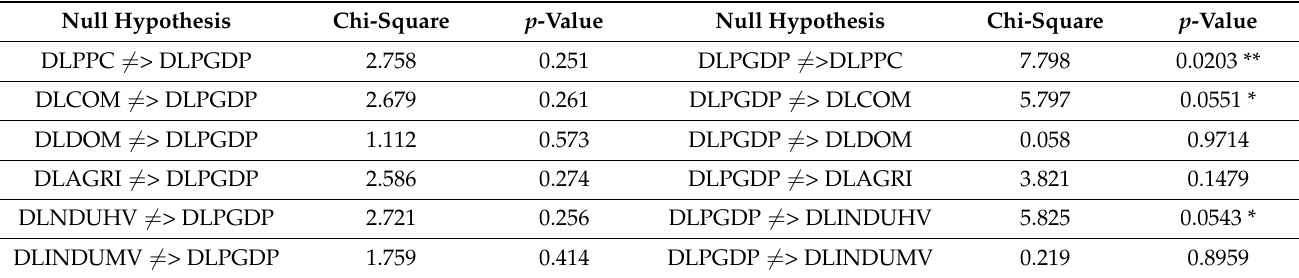
Table 4. VEC Causality